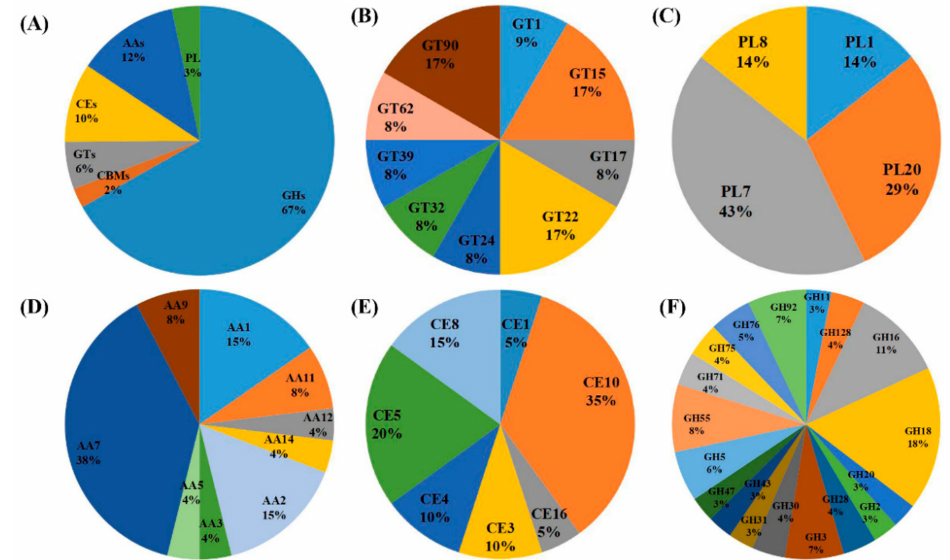
Figure 3. CAZymes identified in the secretome of T. asperellum ND-1. ( A ) Summary of the six CAZyme categories: auxiliary activities (AAs), carbohydrate- binding modules (CBMs), polysaccharide lyases (PLs), glycoside hydrolases (GHs), glycosyl transferases (GTs), and carbohydrate esterases (CEs). ( B ) Distinct summaries of the CAZyme GTs. ( C ) Distinct summaries of the CAZyme PLs. ( D )